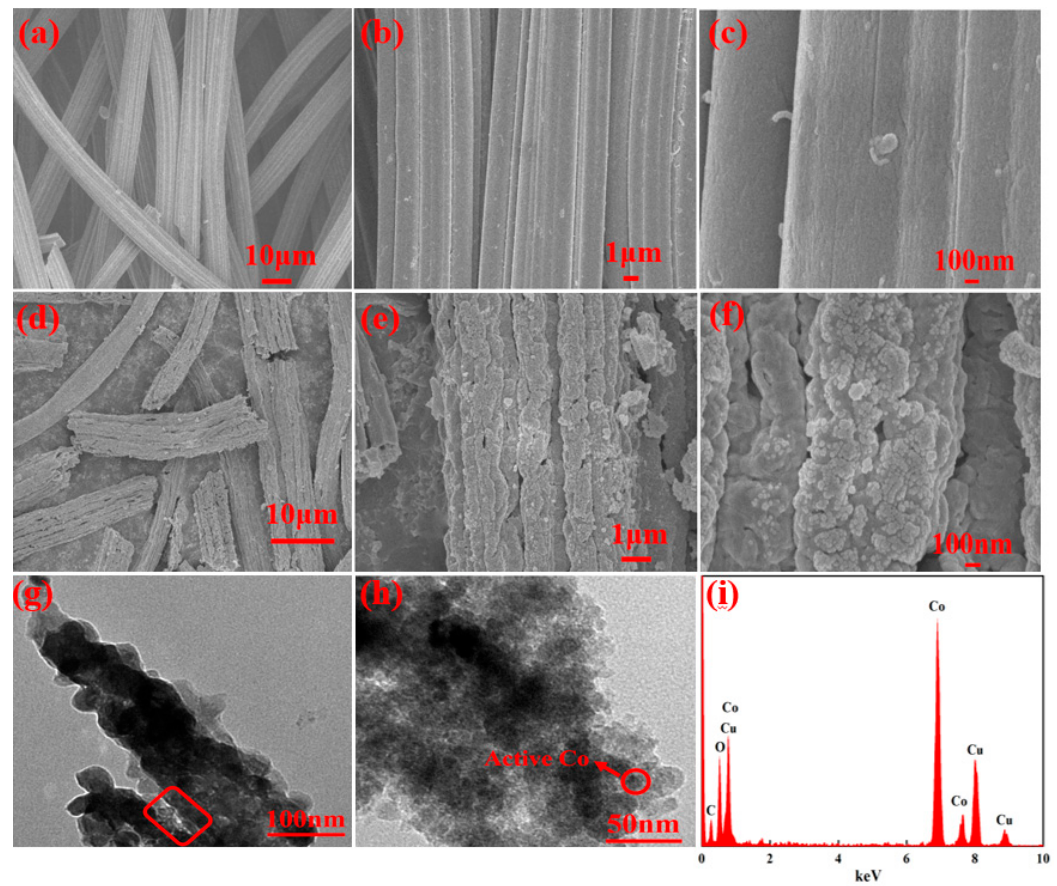
Figure 1. SEM images of ( a , b , c ) ACFs after acid treatment; ( d , e , f ) 40% Co-ACFs and ( g , h ) TEM image and ( i ) EDS pattern of 40% Co-ACFs.